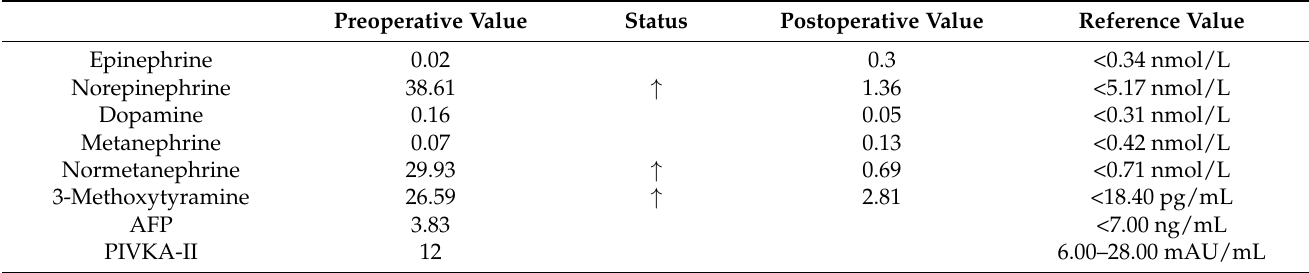
Figure 1. Abdominal contrast-enhanced CT images of the liver. ( A ) Non-enhanced scan shows a hypodense, well-marginated mass, measuring 6.5 × 5.7 cm. ( B – D ) A round inhomogeneous enhancement lesion in the early arterial phase and slight washout in the portal phase. White arrows indicate the liver lesion. Table 1. Plasma catecholamines measurements confirmed the paraganglioma